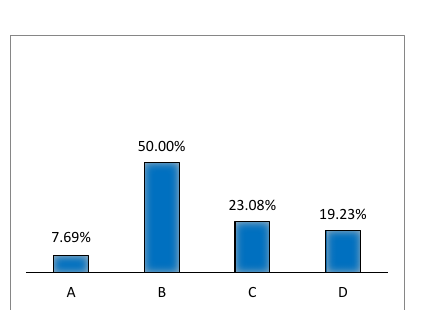
Figure 13. Would you recommend this course to other